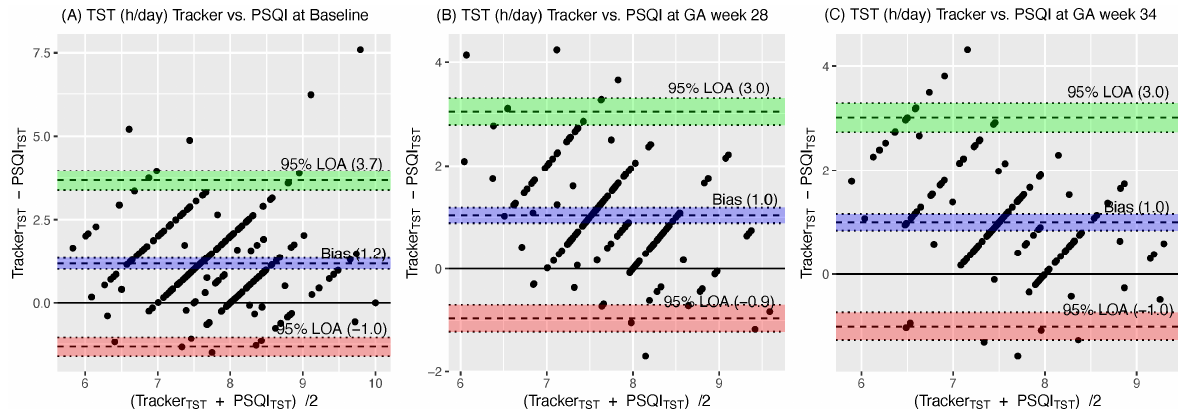
Figure 5. Differences in the total sleep time between the Pittsburgh Sleep Quality Index (PSQI) and the activity tracker vs. the average of sums at the gestational age of maximum 15 weeks ( A ), GA week 28 ( B ), GA week 34 s ( C ). h, hour; GA, gestational age; TST, total sleep time; LOA, the limit of agreements.